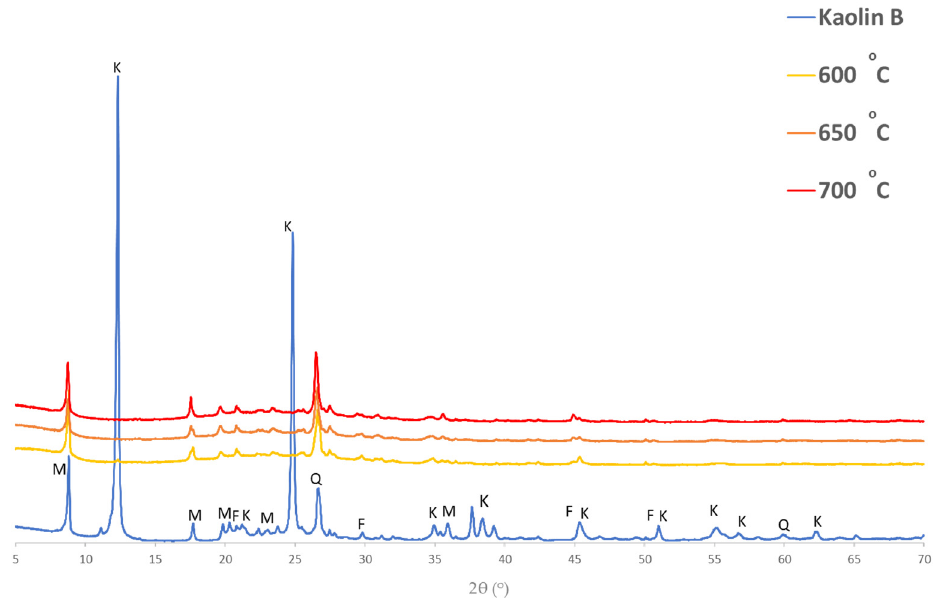
Figure 2. XRD patterns for Kaolin B and its calcined products in 600, 650 and 700 ◦ C (K: Kaolinite M: Mica minerals F: Feldspar minerals Q: